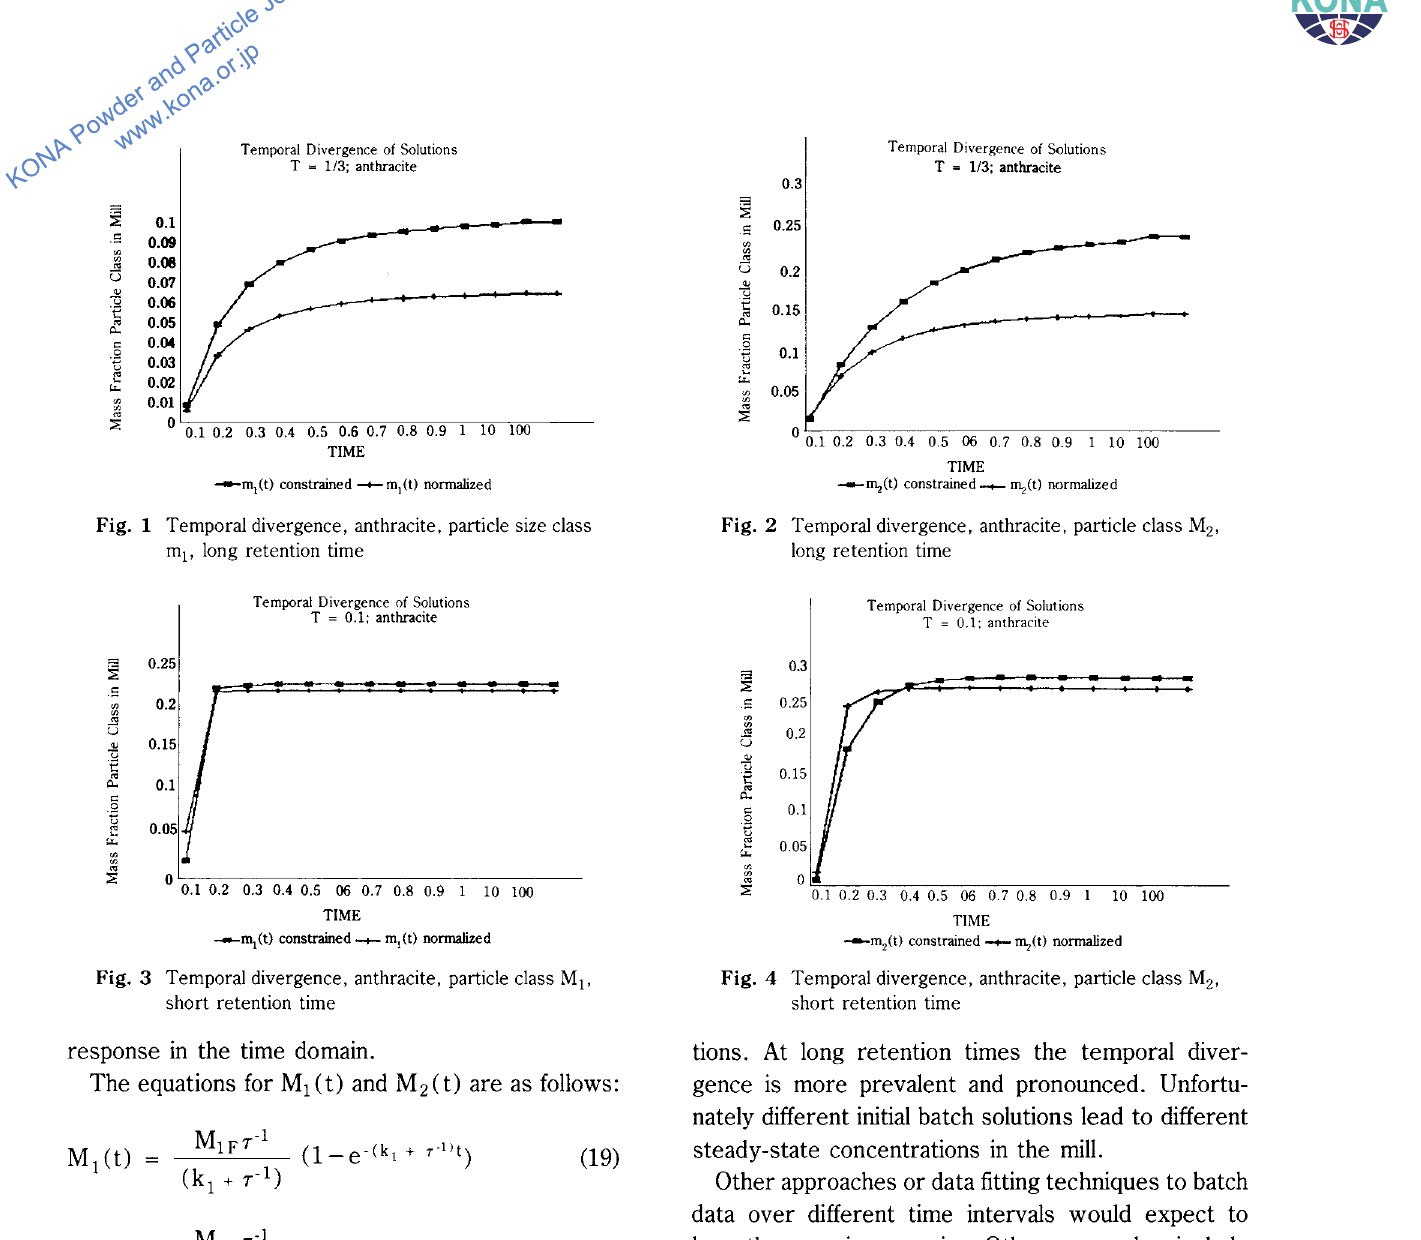
Fig. 4 Temporal divergence, anthracite, particle class M 2, short retention